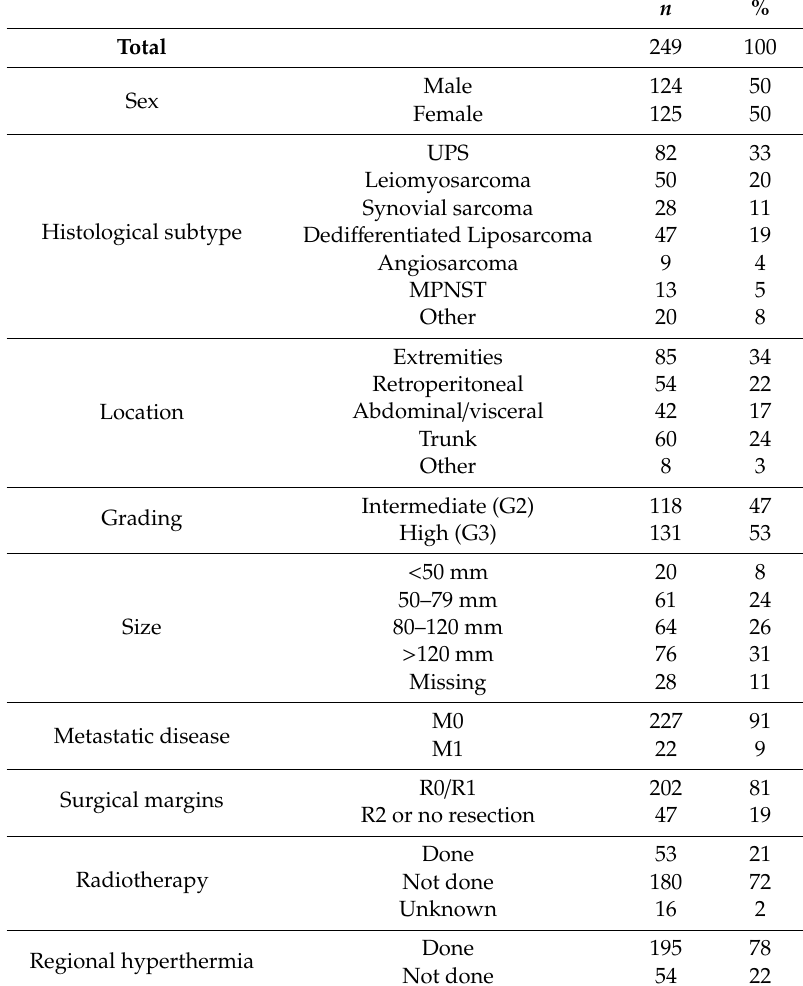
Table 1. Patient Characteristics. UPS: undi ff erentiated pleomorphic sarcoma; SFT: solitary